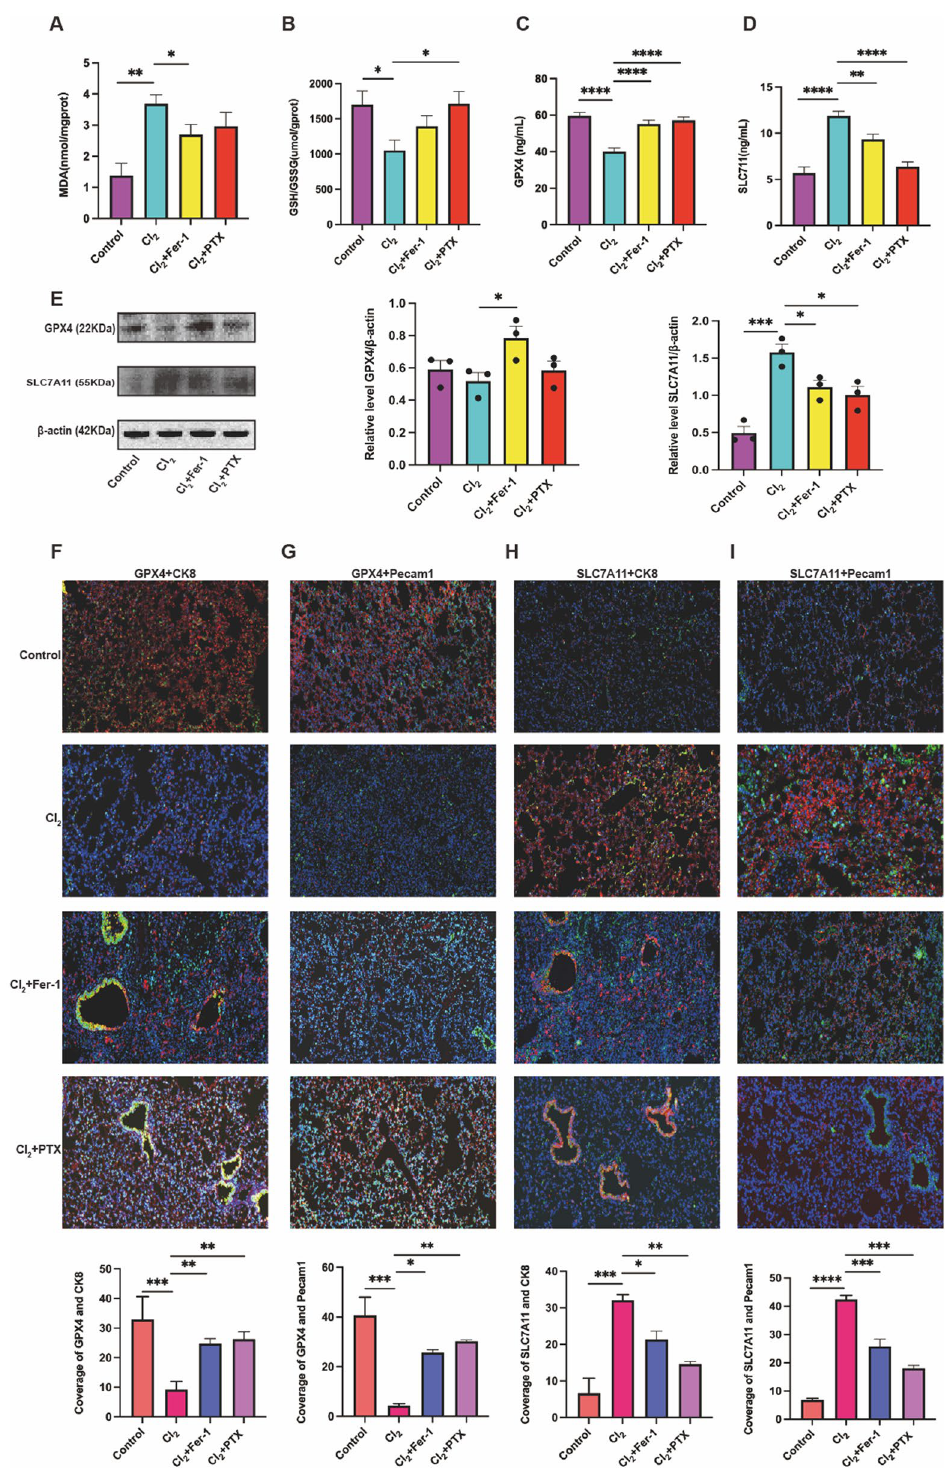
Figure 8. PTX inhibit Cl 2 -induced ferroptosis. ( A , B ) The expression levels of MDA, GSH/GSSG in mice serum treated with Cl 2 , n = 8. ( C , D ) Protein levels of GPX4 and SLC7A11 in mice lung and serum treated with Cl 2 , n = 8. ( E ) GPX4 and SLC7A11 protein levels were determined by western blot analysis, and standardized to the expression of β-actin. Original scans of whole blots are shown in Supplementary information 5. ( F , G ) Immunofluorescence images were used to detect the expression of GPX4 in epithelial and endothelial cells, scale bars 50 μm, n = 6. ( H , I ) Immunofluorescence images were used to detect the expression of SLC7A11 in epithelial and endothelial cells, scale bars 50 μm, n = 6. Epithelial cell: CK8 (green), endothelial cells: Pecam1 (green), GPX4 (red), SLC7A11 (red), cell nuclear (blue). The data was shown as mean ± SEM, * P < 0.05, ** p < 0.01, p < 0.001, **** p < 0.0001, n =